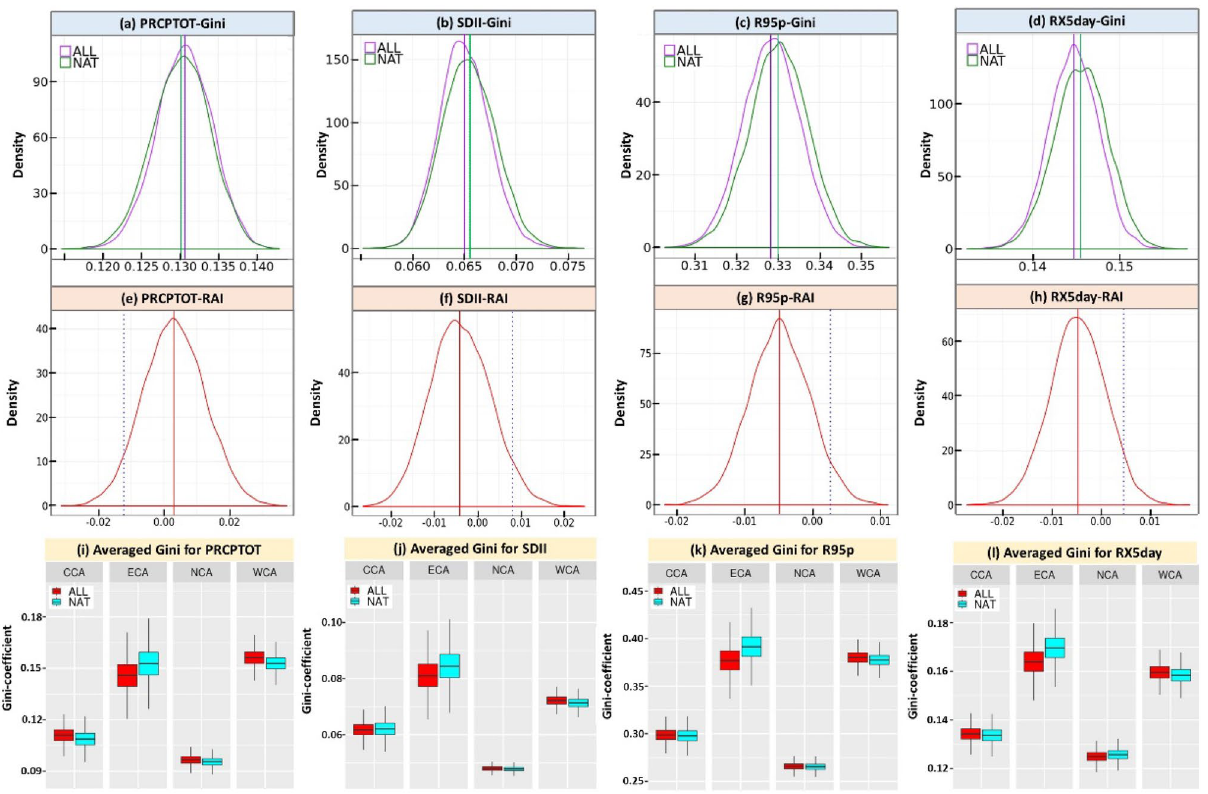
Figure 4. The probability distribution of the resampled averaged Gini coefficients for the ( a ) PRCPTOT, ( b ) SDII, ( c ) R95p and ( d ) RX5day, the distribution of the RAI values for the ( e ) PRCPTOT, ( f ) SDII, ( g ) R95p and ( h ) RX5day, and the boxplots of the resampled averaged Gini-coefficients for the ( i ) PRCPTOT, ( j ) SDII, ( k ) R95p and ( l ) RX5day regarding 4 sub-regions in CA, CMIP5 ALL and NAT scenario obtained by the bootstrapping procedure. The dash- lines in figures ( a – d ) represent the median (best estimate) value of the Gini-coefficients. The solid lines in figures ( e – h ) demonstrate the median (best estimate) value of the RAI and the dash- line indicates the 95th percentile value. The subfigures were done in the software R 4.0.2 (https:// cran.r- proje ct. org/ bin/ windo ws/), and then the subfigures were merged by using the Microsoft PowerPoint 2013 software (https:// www. micro soft.